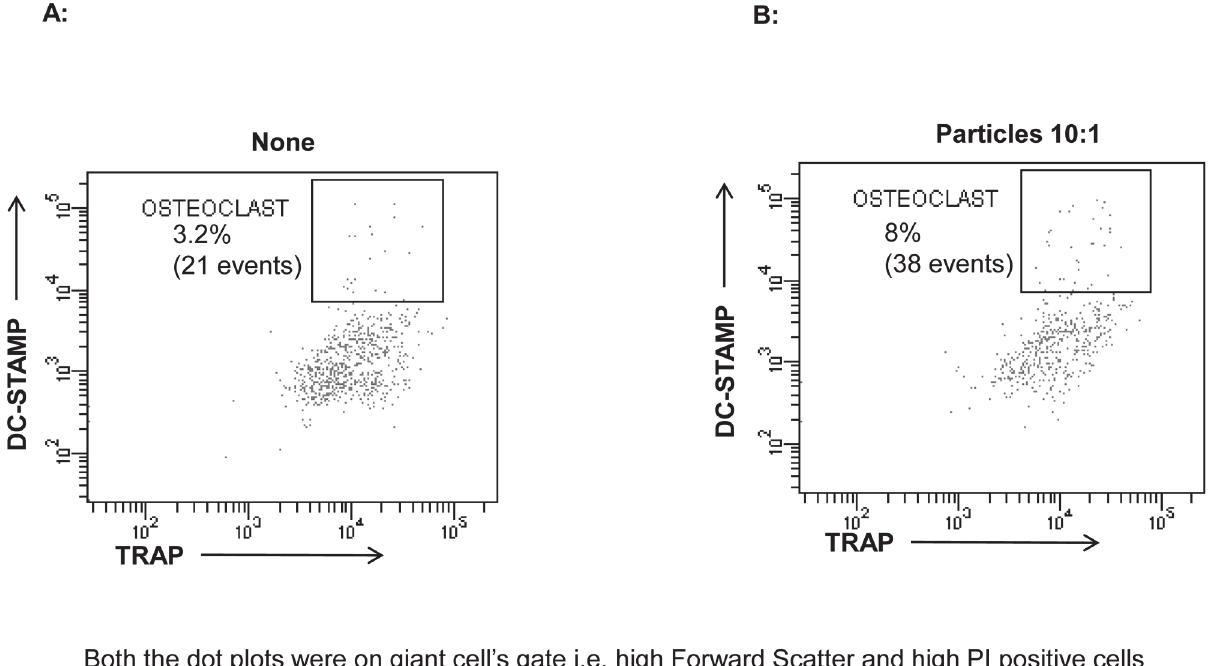
Fig 6. Particles at 10:1 ratio induced protein expression the DC-STAMP and TRAP in day 14 cultures. As described above, co-cultures were set up at 10:1 ratio and incubated for 14 days. Cells were harvested by collagenase treatment, washed and intracellular stained with propidium iodide, FITC conjugated- TRAP and APC conjugated-DC-STAMP. Both the dot plots (A and B) were first gated for giant cell i.e. high Forward Scatter and high PI positive cells, and then for DC-STAMP and TRAP. Cells without particles are represented in (A) and with particles in (B).